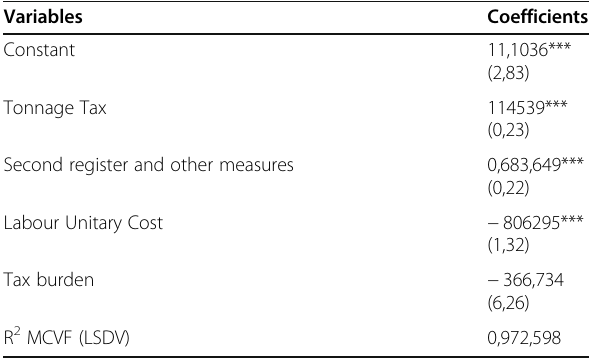
Table 6 Regression estimates of impact of maritime transport policy measures on controlled fleet (general